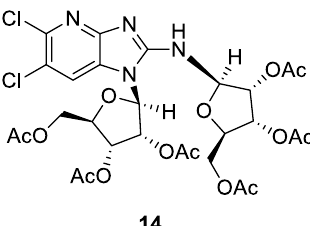
Figure 2. Structure of di-ribosylated by-product formed upon glycosylation of the amino derivative 7d .